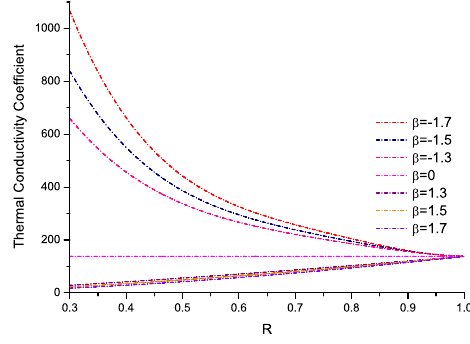
Figure 11: Variation of normalized axial stress with Poisson’s ratio